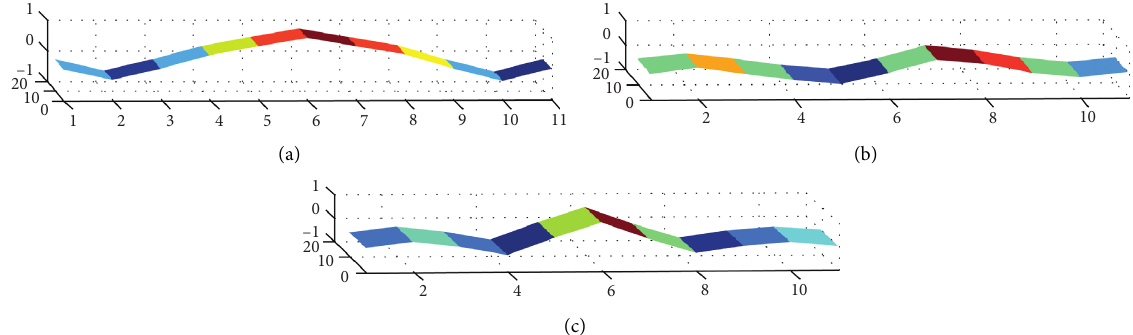
Figure 20: Modal shape diagrams of the top three orders (algorithm of this paper). (a) The first-order mode shape. (b) The second-order mode shape. (c) The third-order mode shape.